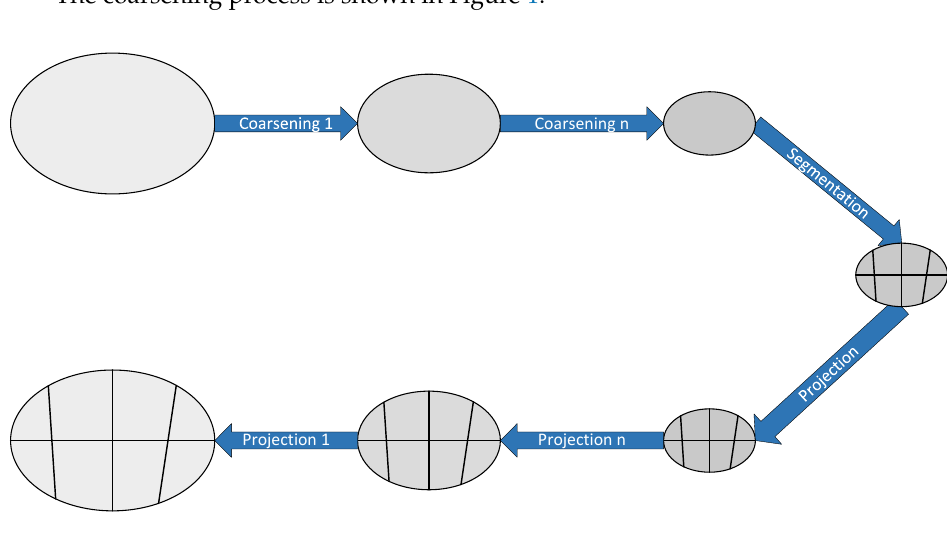
Figure 1. The coarsening